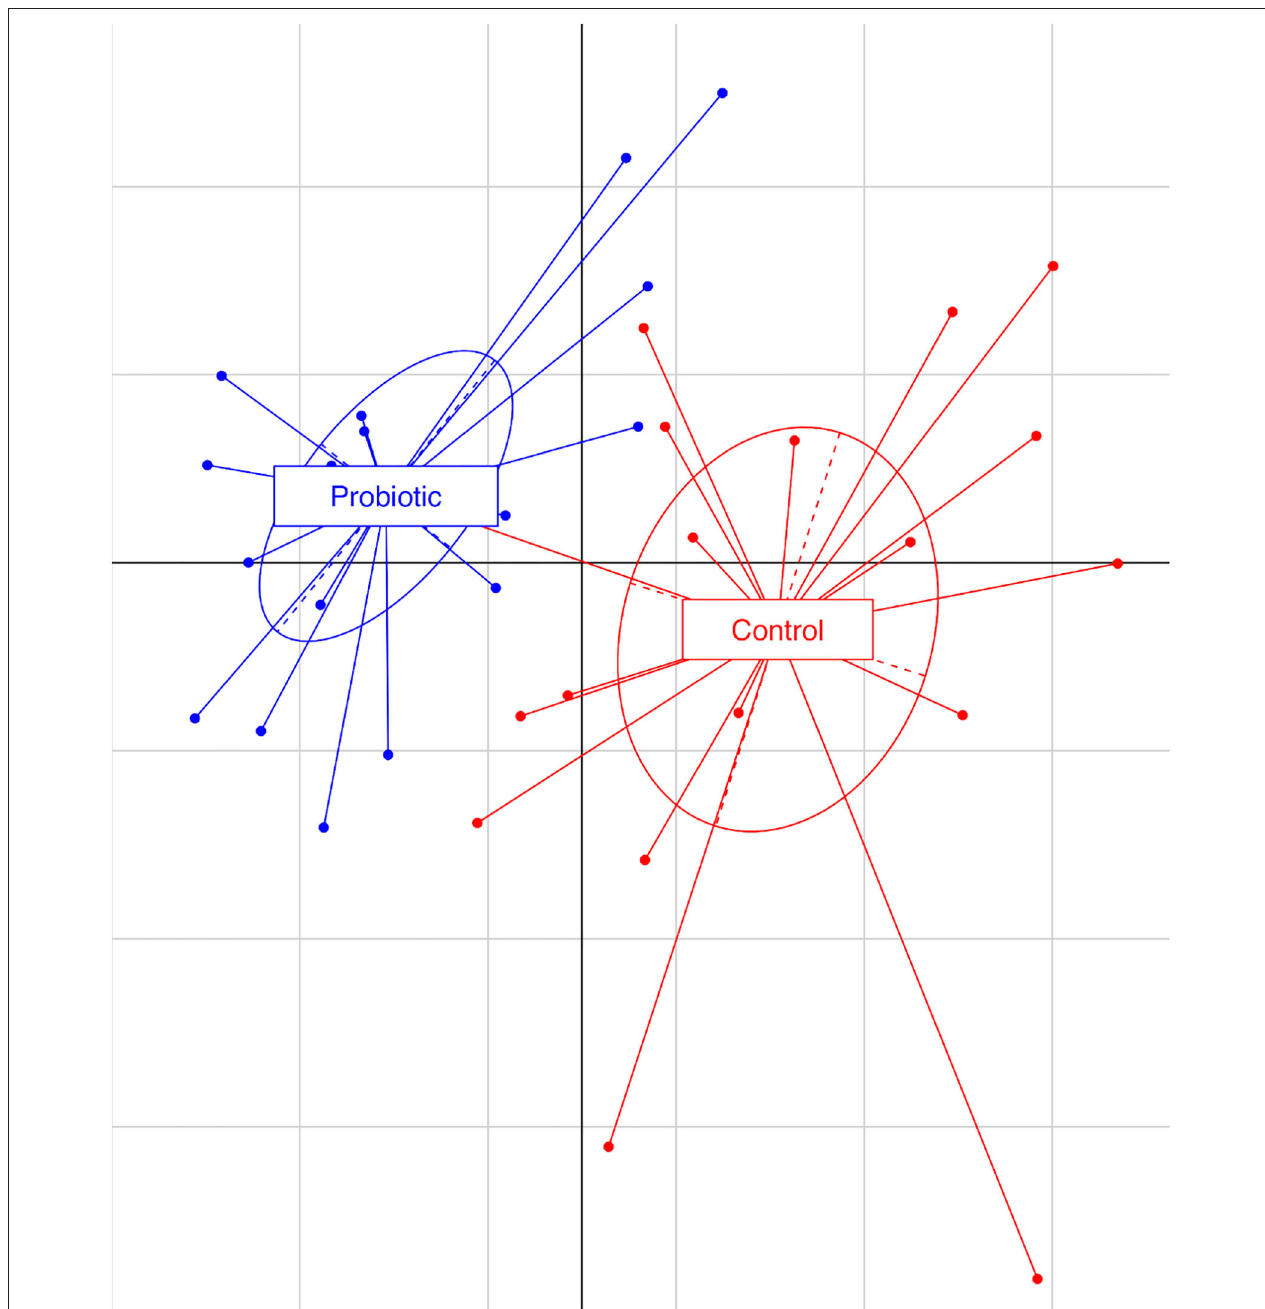
FIGURE 2 | Principal component analysis based on observational taxonomic units (OTUs) relative abundance. The first component (horizontal) accounts for the 17.04% of the variance and the second component (vertical) accounts for the 12.73%. Blue dots represent the treated group (P), receiving water plus a commercial multi-strain probiotic (Slab51 ® ), red dot represent the control group